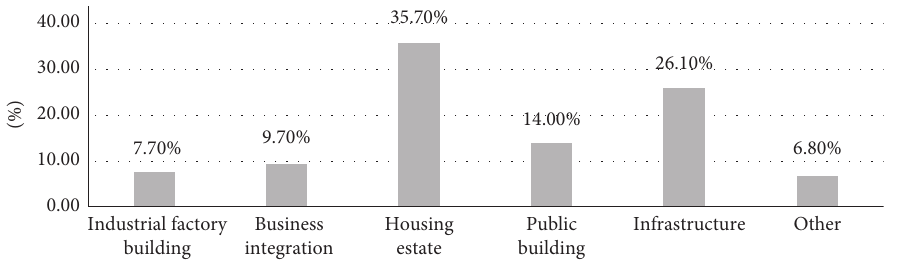
Figure 3: Project